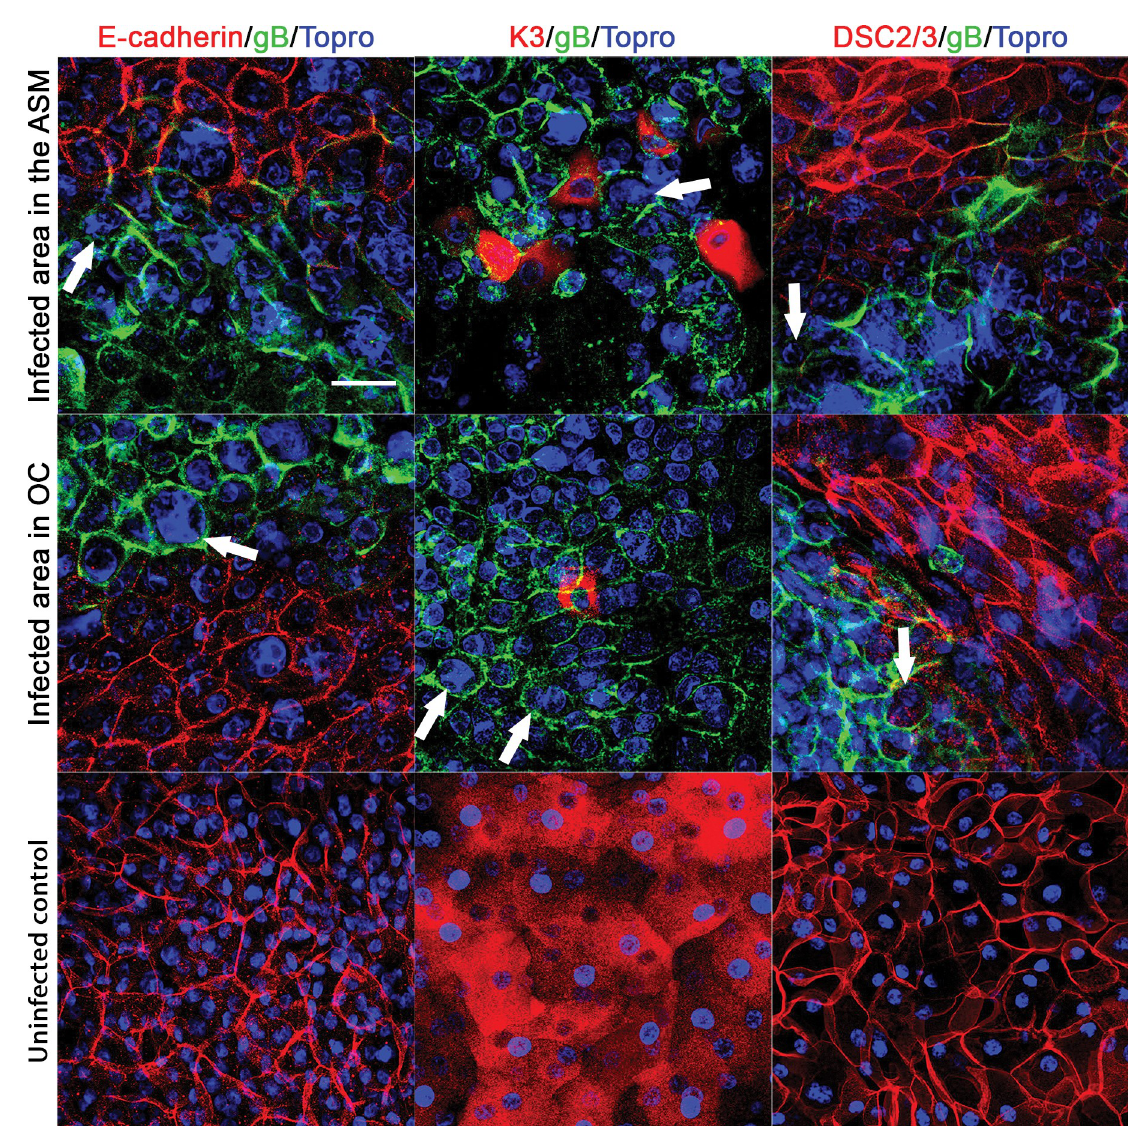
Fig 4. En face view of the corneal epithelium after HSV-1 infection. Confocal microscopy of corneal epithelium infected in the active storage machine or in organ culture and labelled with anti-gB/E-cadherin after methanol fixation or K3 or DSC2/3 after 0.5% PFA fixation, a mean 5 days after HSV-1 inoculation. The white arrows show the rounded infected cells exhibiting the HSV-1 induced cytopathogenic effect with a higher nuclear-cytoplasmic ratio. No gB staining was observed in negative controls. Nuclei were stained with To-PRO 3 Iodide. Scale bar: 50 μ